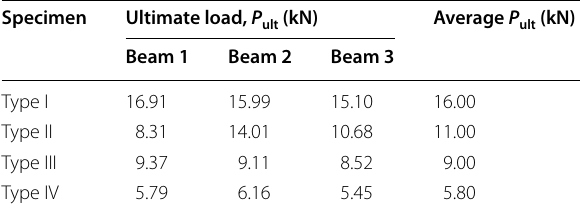
Table 3 Maximum static load for each type of specimen.